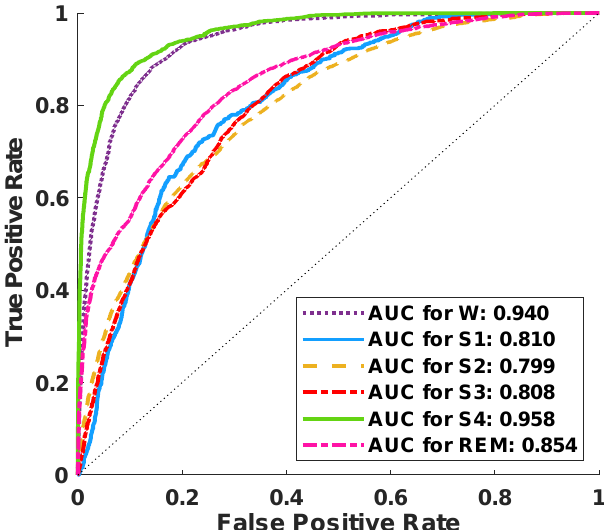
Figure 4. ROC curves obtained for the classifier whole database using the EBT with 10-fold